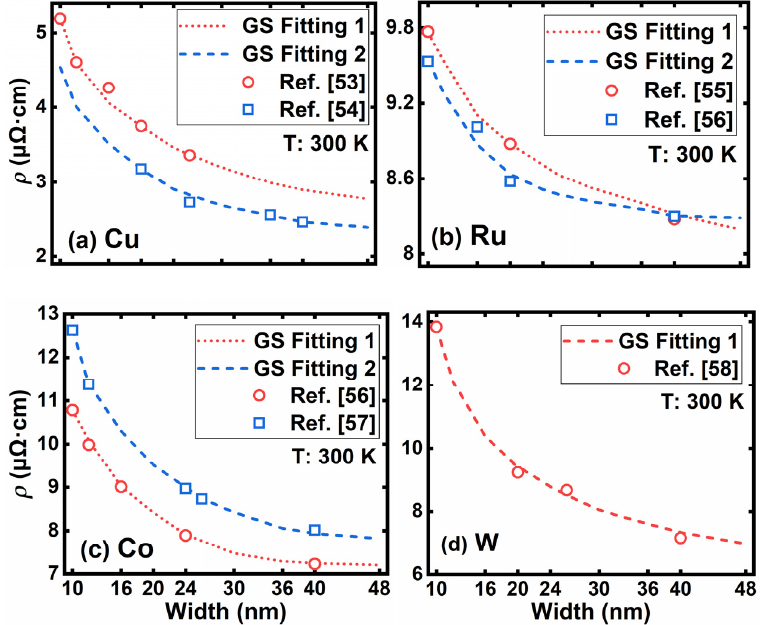
Figure 8. The fitting results of ( a ) Cu, ( b ) Ru, ( c ) Co, and ( d ) W with linewidth scaled from 48 nm to 10 nm. Hollow dots represent the experimental data, and the dashed lines are the simulation results with fitted grain sizes. Table 3. Extracted grain sizes for Cu, Ru, Co, and W from experimental data. Width (nm)